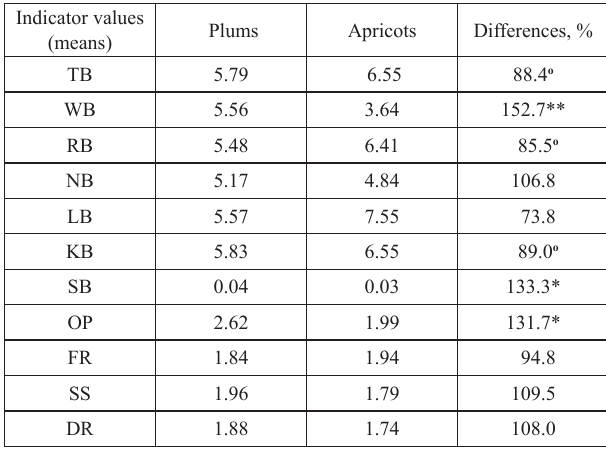
values on two fruit species (The plums were in Intern. J. Hort. Sci.